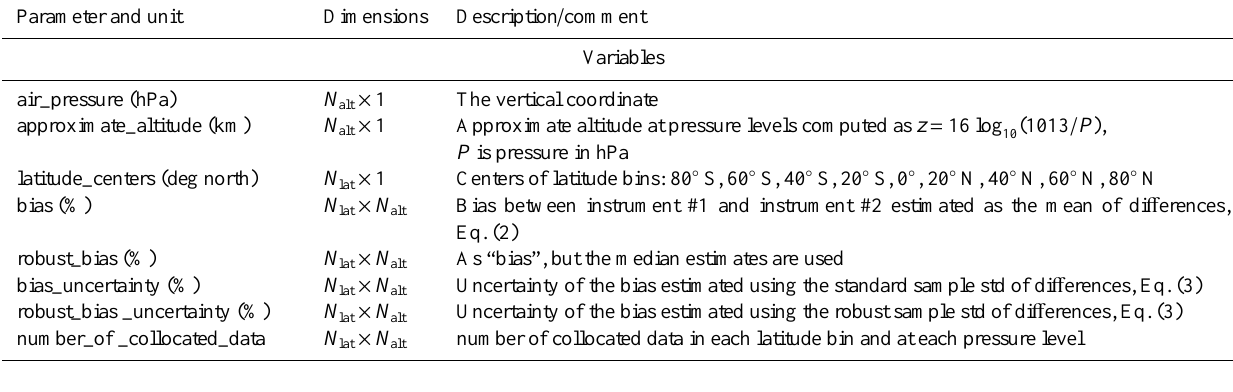
Table 5. Main parameters of bias tables in the netCDF format.